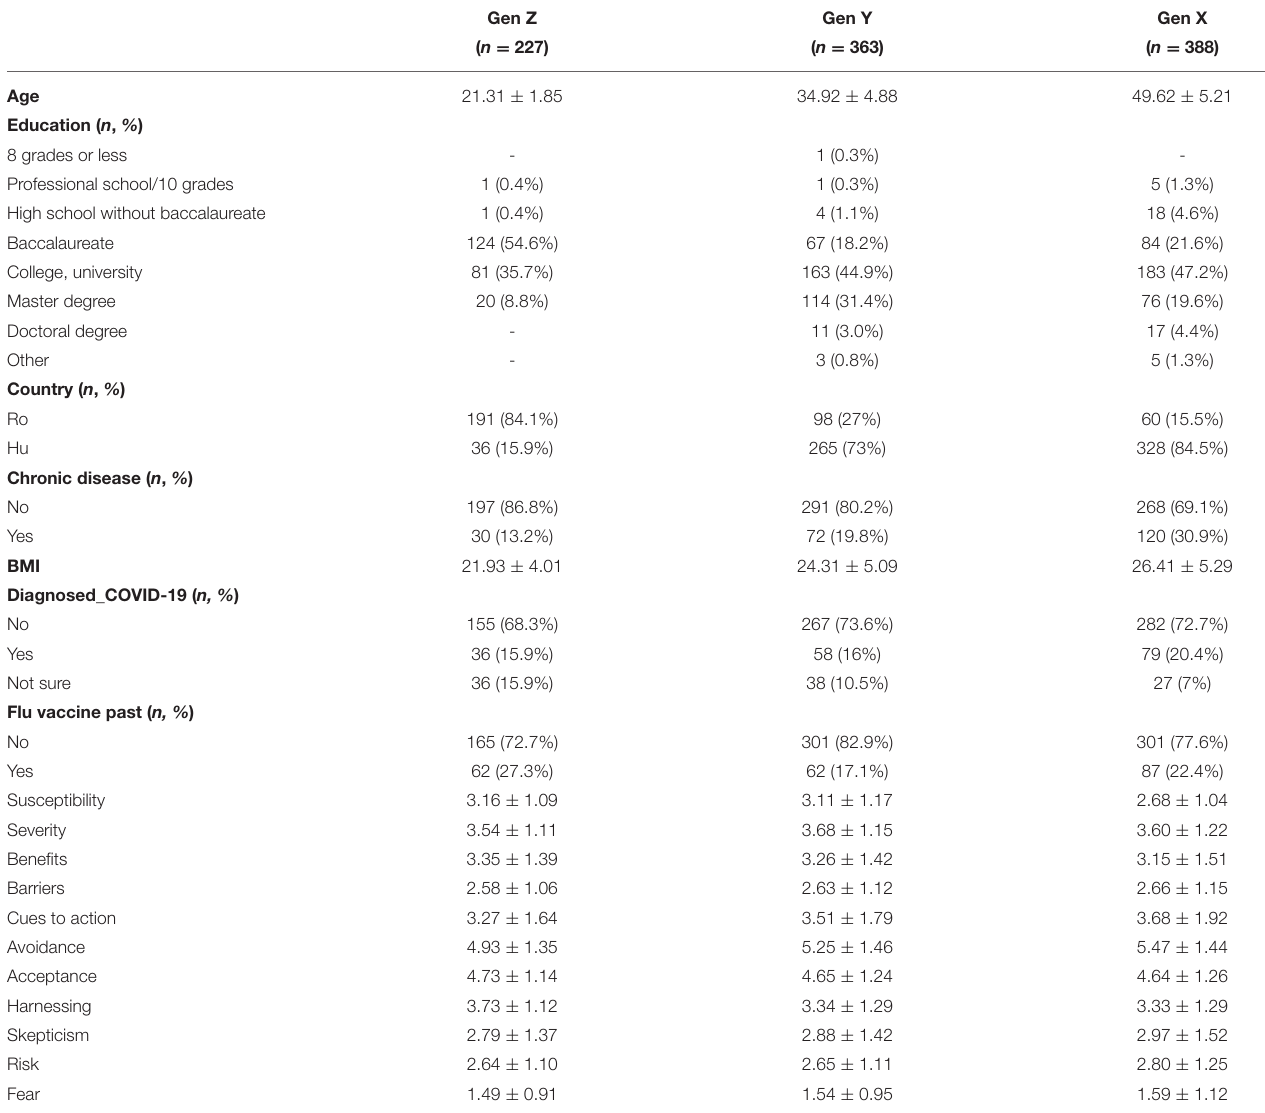
TABLE 1 | Baseline characteristics of the participants ( N =